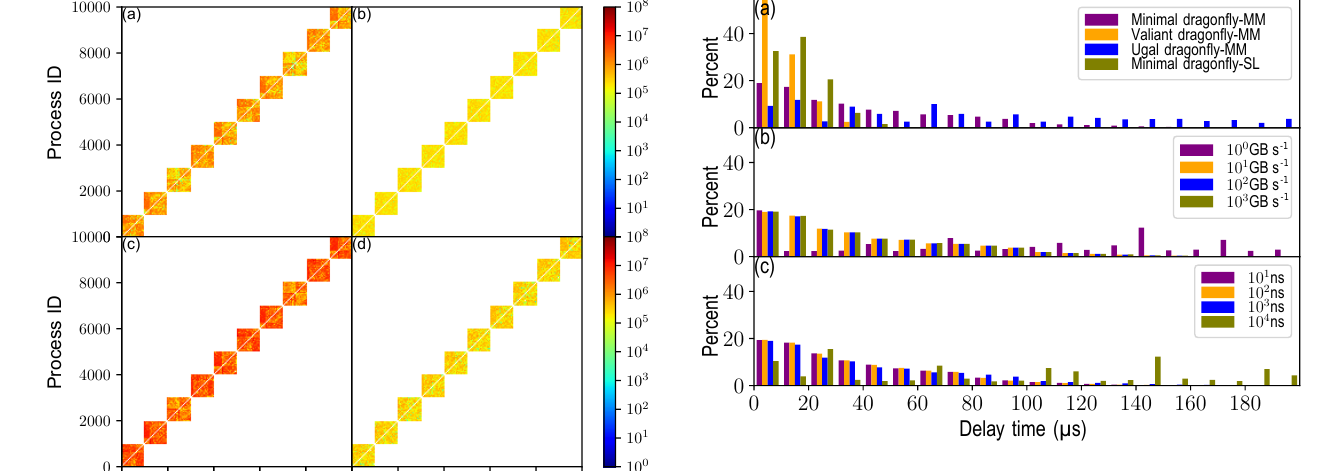
Figure 8. Distribution of delayed events of transposition for the spectral transform method with 10 4 MPI processes using (a) dif- ferent routing algorithms and topology configurations, (b) different bandwidths, and (c) different latencies, simulated by